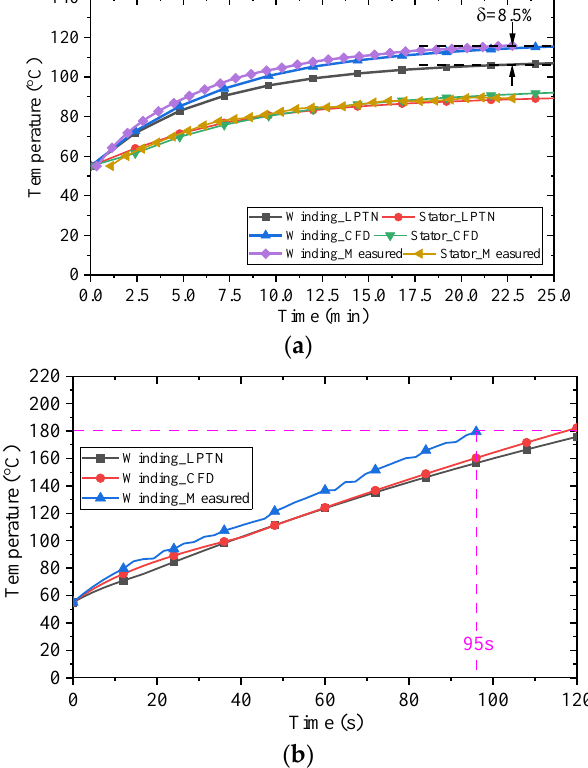
Figure 10. Comparison of experimental temperature results with calculated results. ( a ) 1500 r/min @ 130 kW. ( b ) 796 r/min @ 200